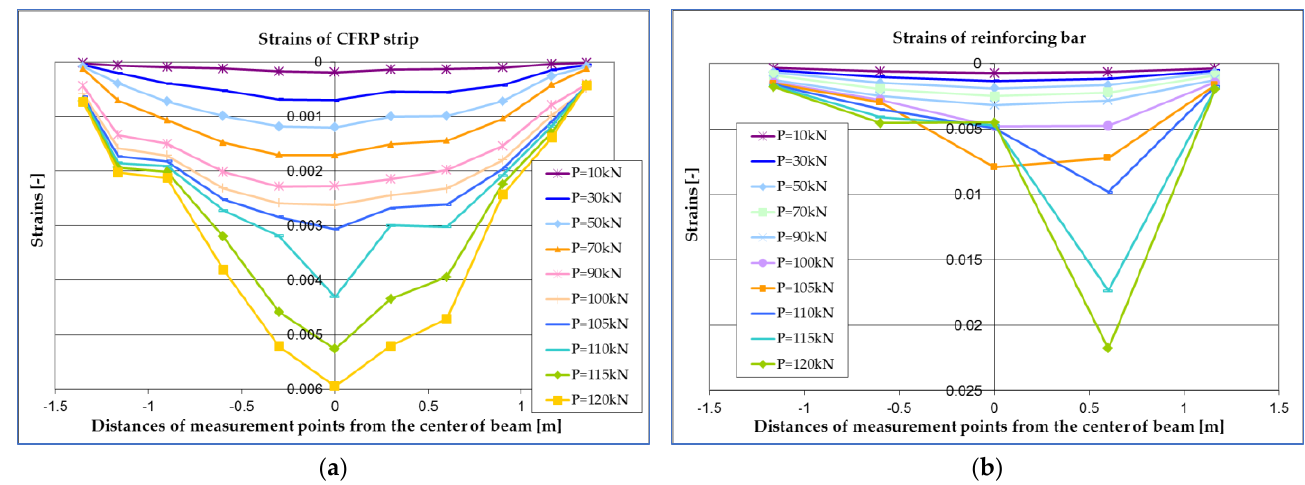
Figure 11. Strains in Boow-3 beam: ( a ) of composite strip and ( b ) of middle reinforcing bar.